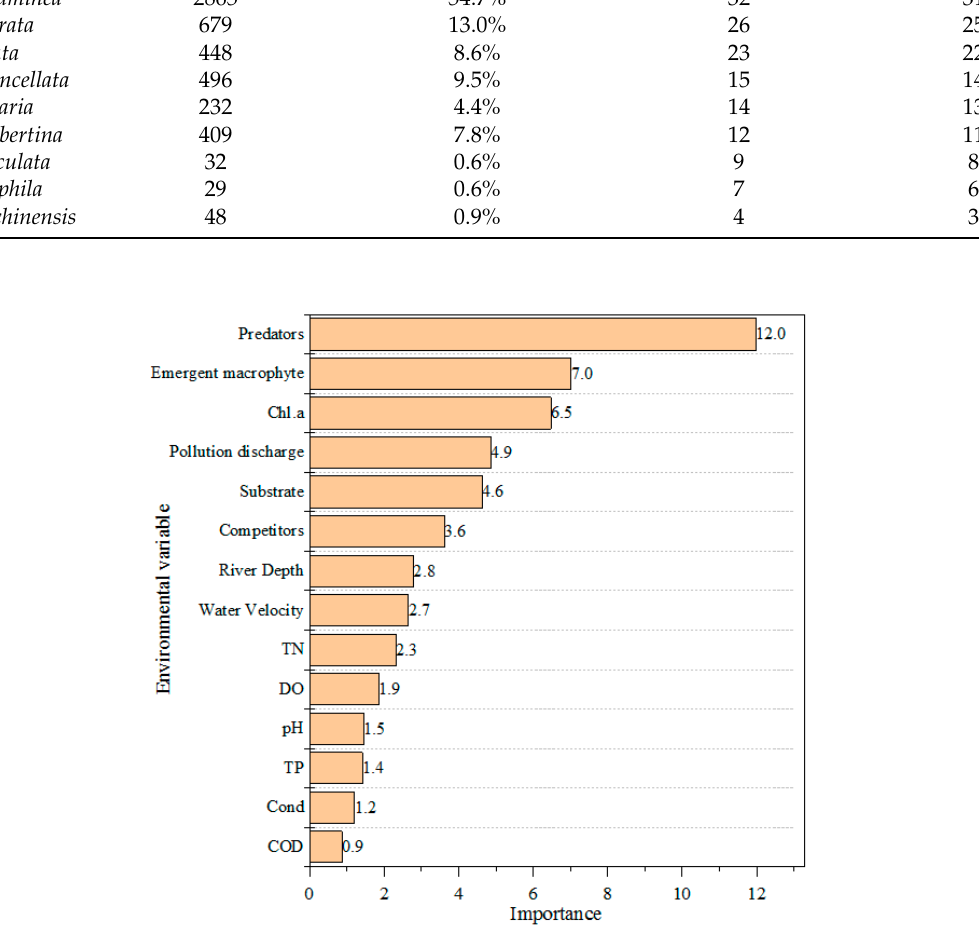
Figure 2. Overview of importance of the different input variables used in the decision tree models to model the presence or absence of each freshwater snail species. The classification tree model for B. straminea is shown in Figure 3. This tree has nine leaves and fifteen branches. The classification tree selected predators’ appearance as the root of the tree, which is considered the most important variable by which to predict the occurrence of B. straminea . That is suggested B. straminea was absent in the presence of predators. In addition, B. straminea was often present in sites where there was lower emer- gent canopy cover, shallow water habitats, and high chlorophyll- a levels (>14.62 μ g/L).